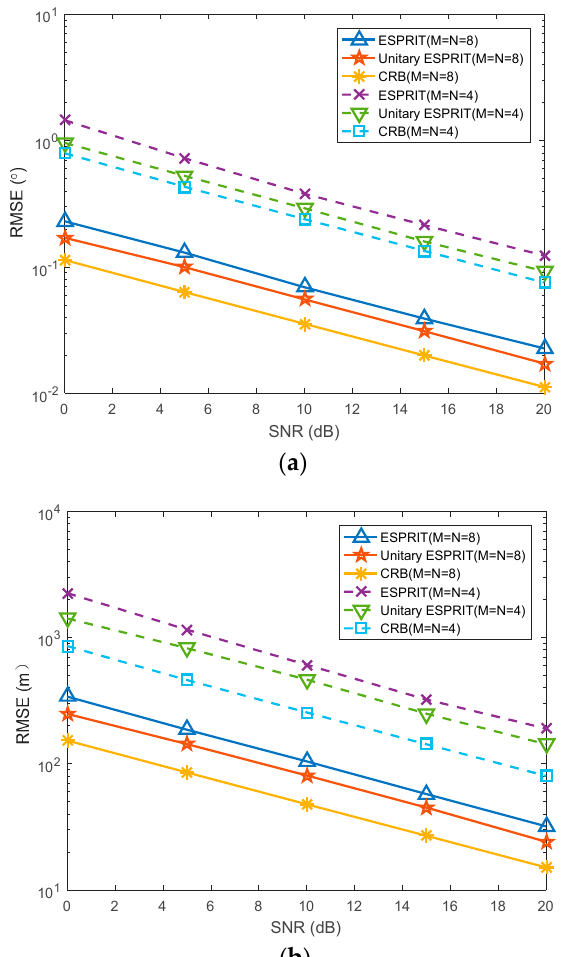
Figure 5. Estimation of target parameters by the proposed algorithm and ESPRIT algorithm with different SNR. ( a ) RMSE of DOA versus SNR; ( b ) RMSE of range versus SNR.